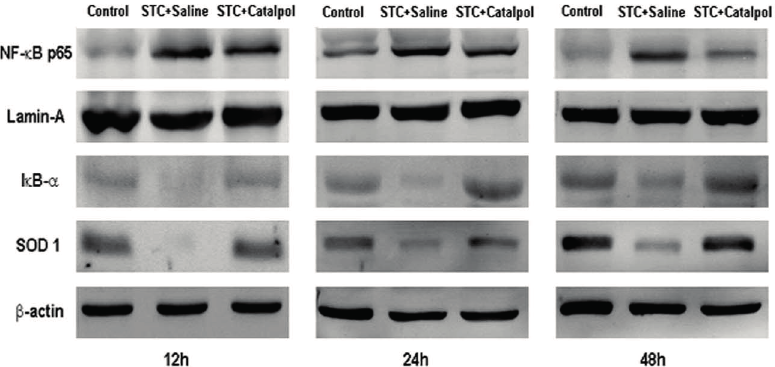
Figure 5. Western blot analysis of NF-  B p65 in the nucleus, and I  B- α and SOD1 in the cytoplasm or whole protein at three time-points for each group. Lamin A and β -actin were used as the internal references for nuclear and cytoplasmic or whole proteins, respectively. Figures are representative of three independent experiments.